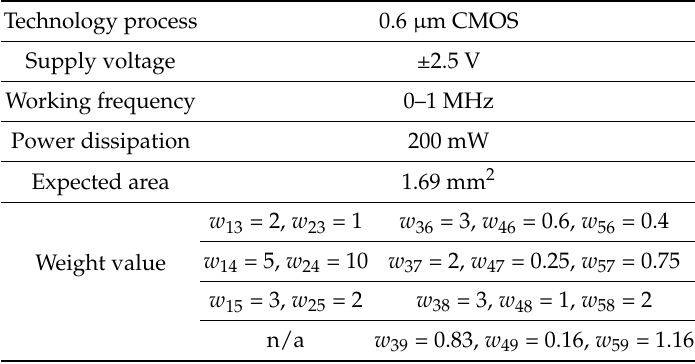
Table 1. The specifications and weights of our 2-3-4 MLP